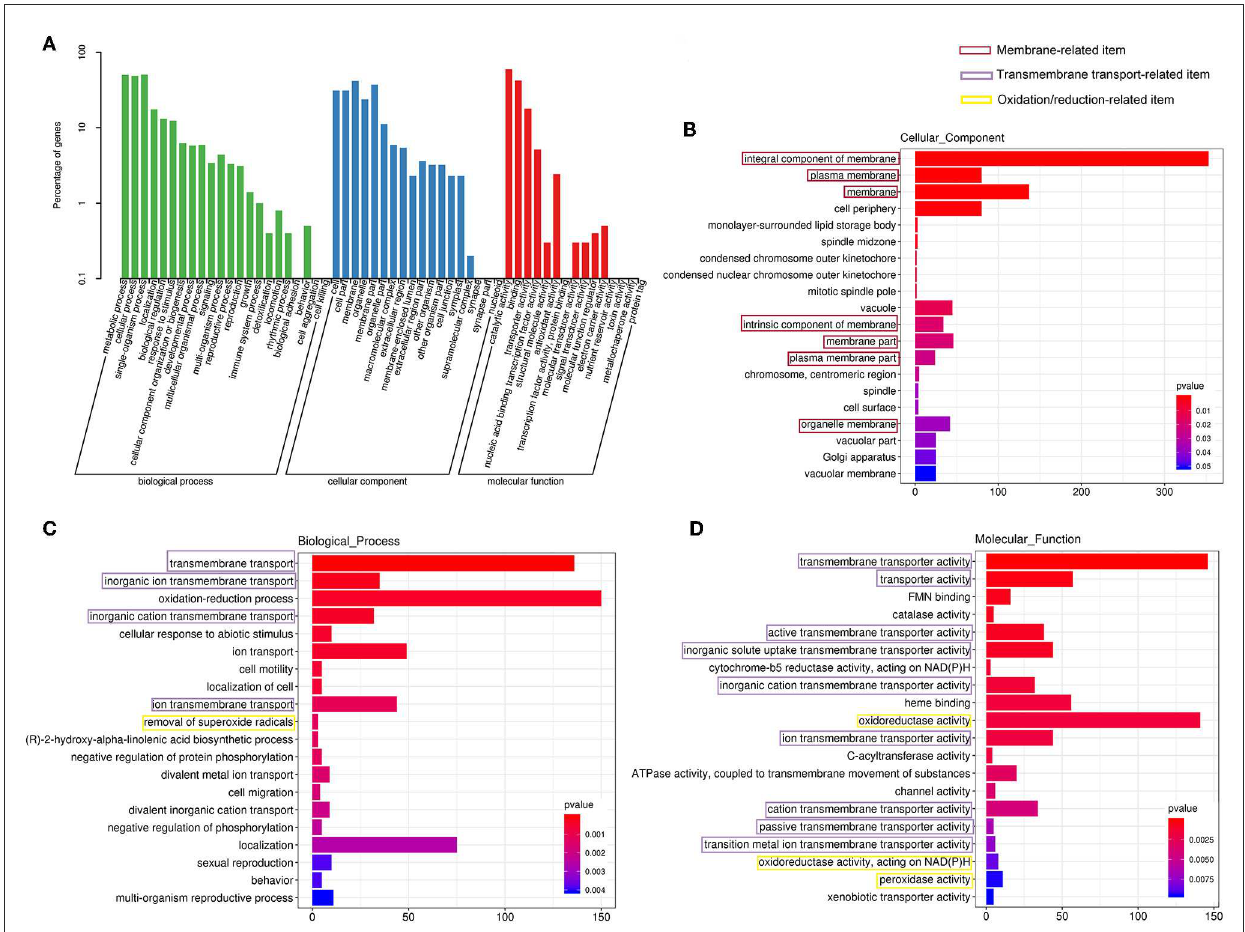
FIGURE7 Gene Ontology (GO) analysis of the differentially expressed genes. (A) The GO classification. GO enrichment for cellular component (B) , biological process (C) , and molecular function (D) category, respectively.